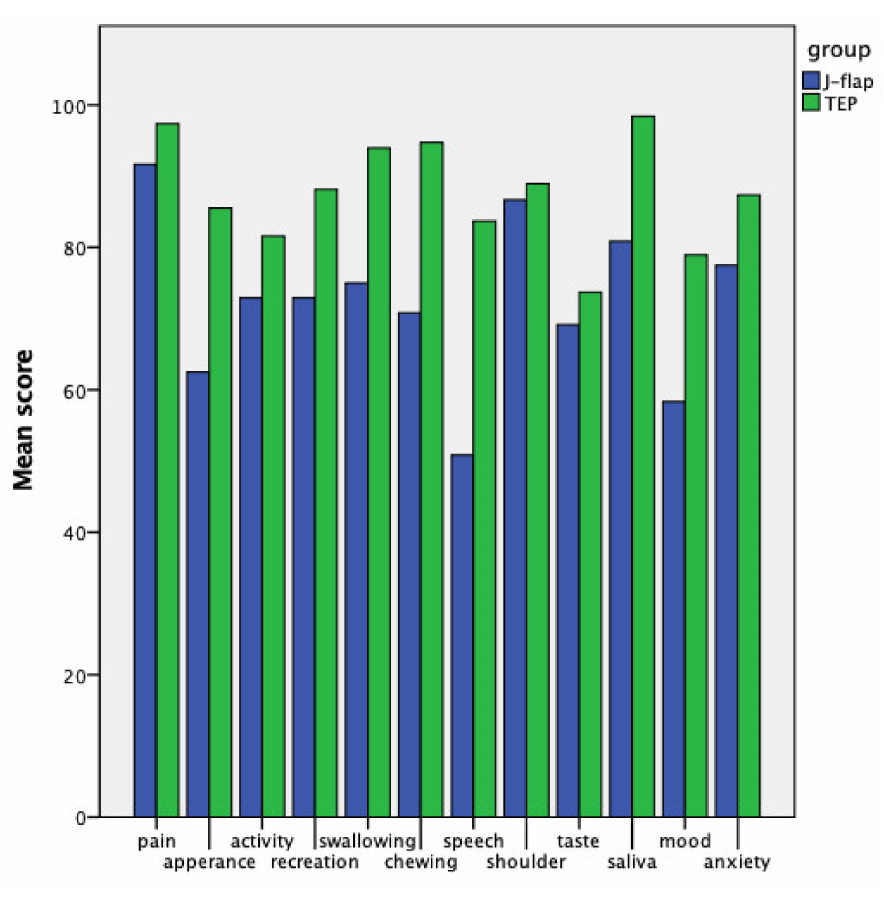
Figure 5. The University of Washington quality of life questionnaire. Table 5. Quality of life